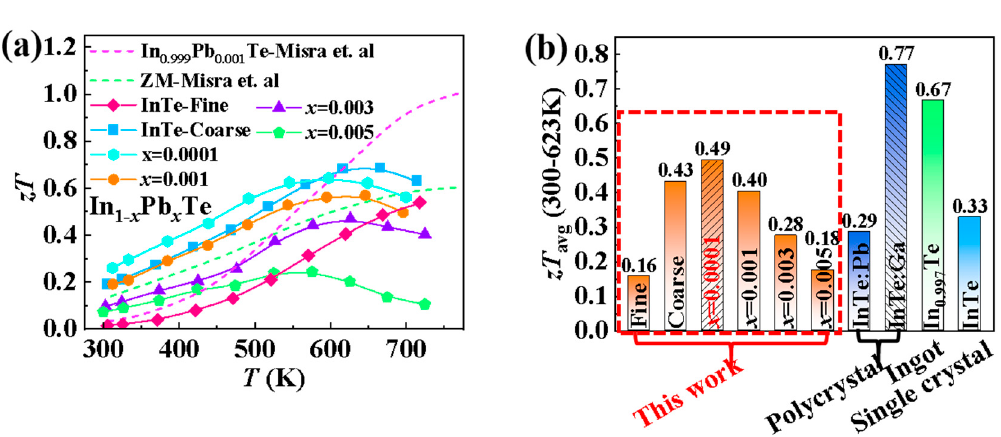
Figure 6. ( a ) Temperature dependence of zT, ( b ) the average zT within 300–623 K for our In 1- x Pb x Te ( x = 0, 0.0001, 0.001, 0.003, 0.005) samples in comparison with the values in other literature [15,16,21,29].